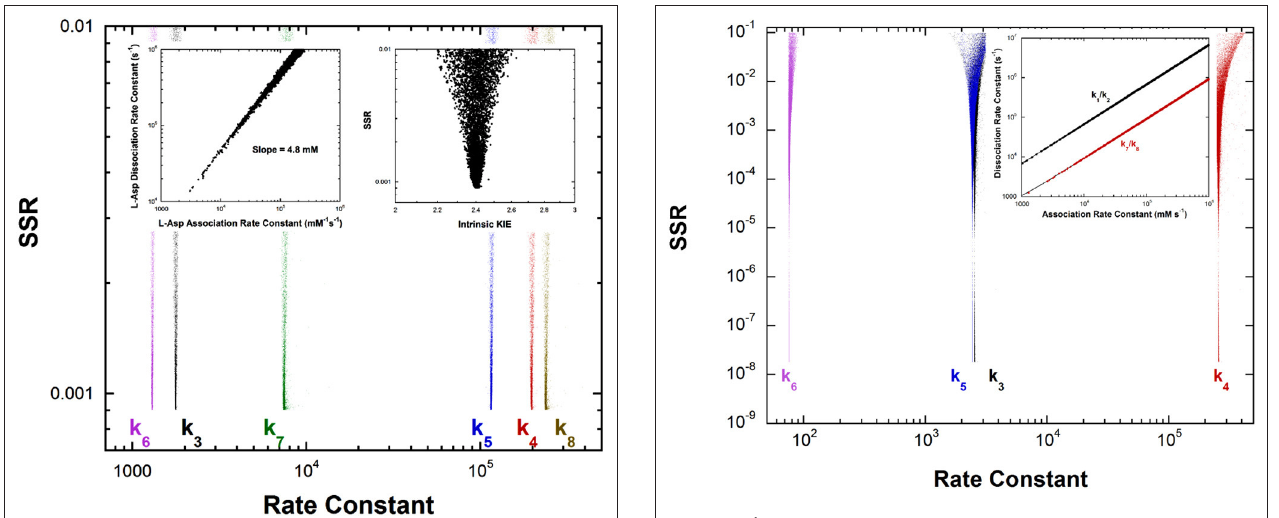
Lys258, which is critical to catalysis (Toney and Kirsch, 1993).